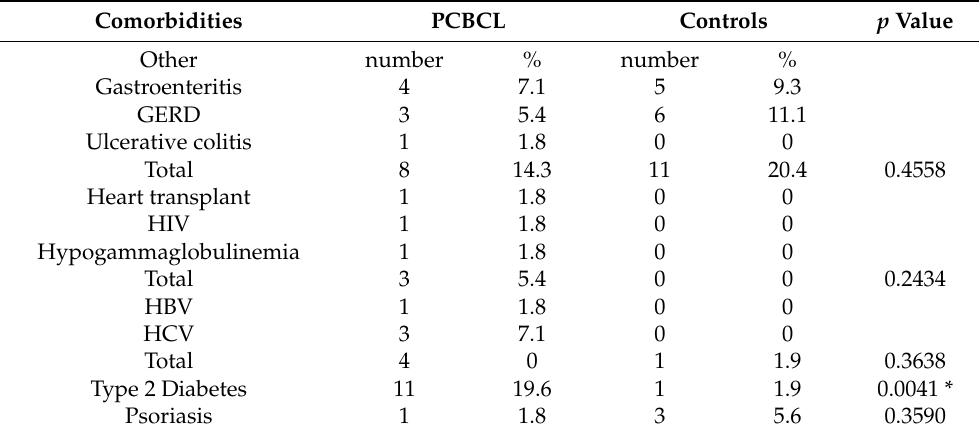
Table 5. Comparison of other comorbidities in patients with PCBCL and